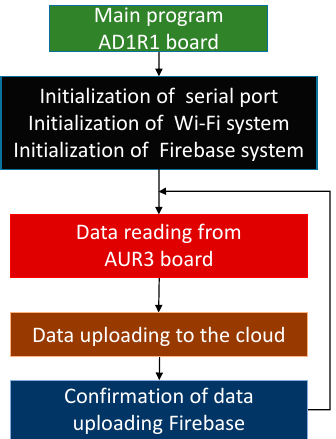
Figure 6. Flowchart for cloud data uploading: AD1R1 board.